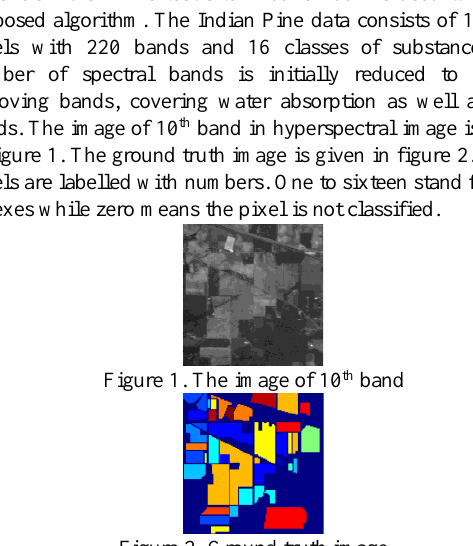
Figure 2. Ground truth image